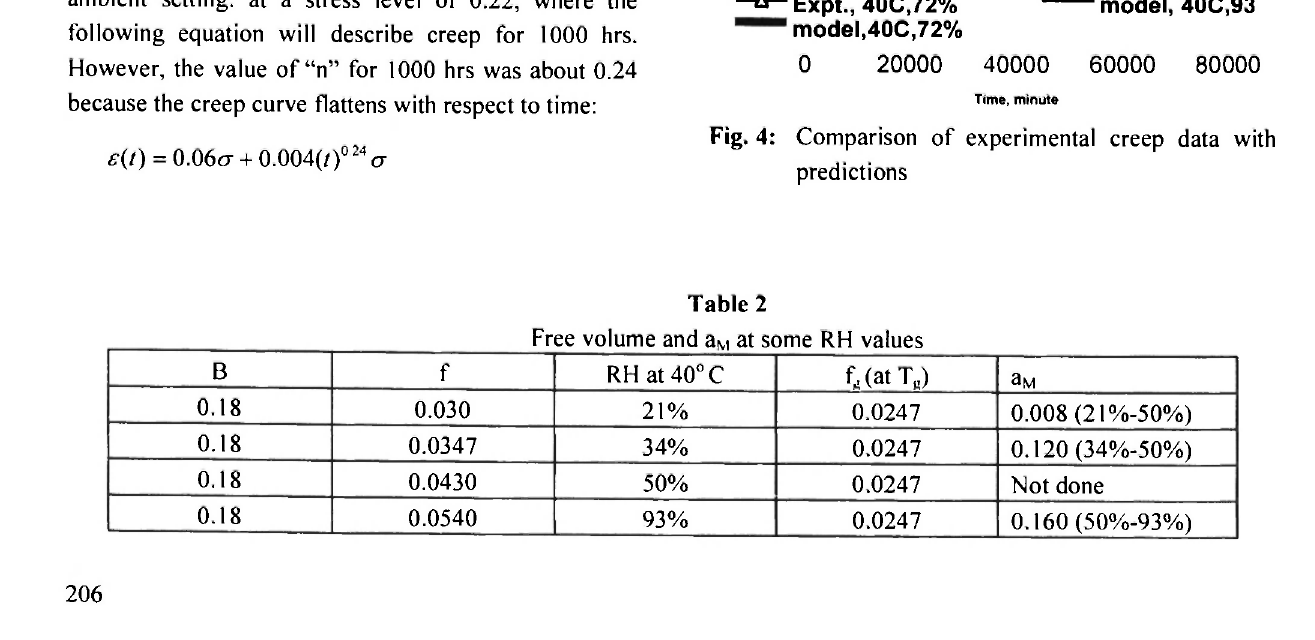
Fig. 4: Comparison of experimental creep data